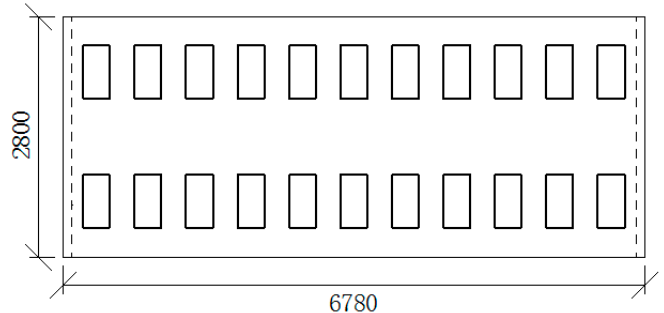
Figure 32. Optimal design of track bed slab length.